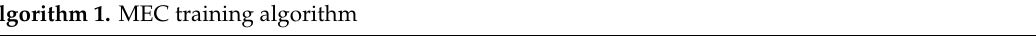
Algorithm 1. MEC training algorithm